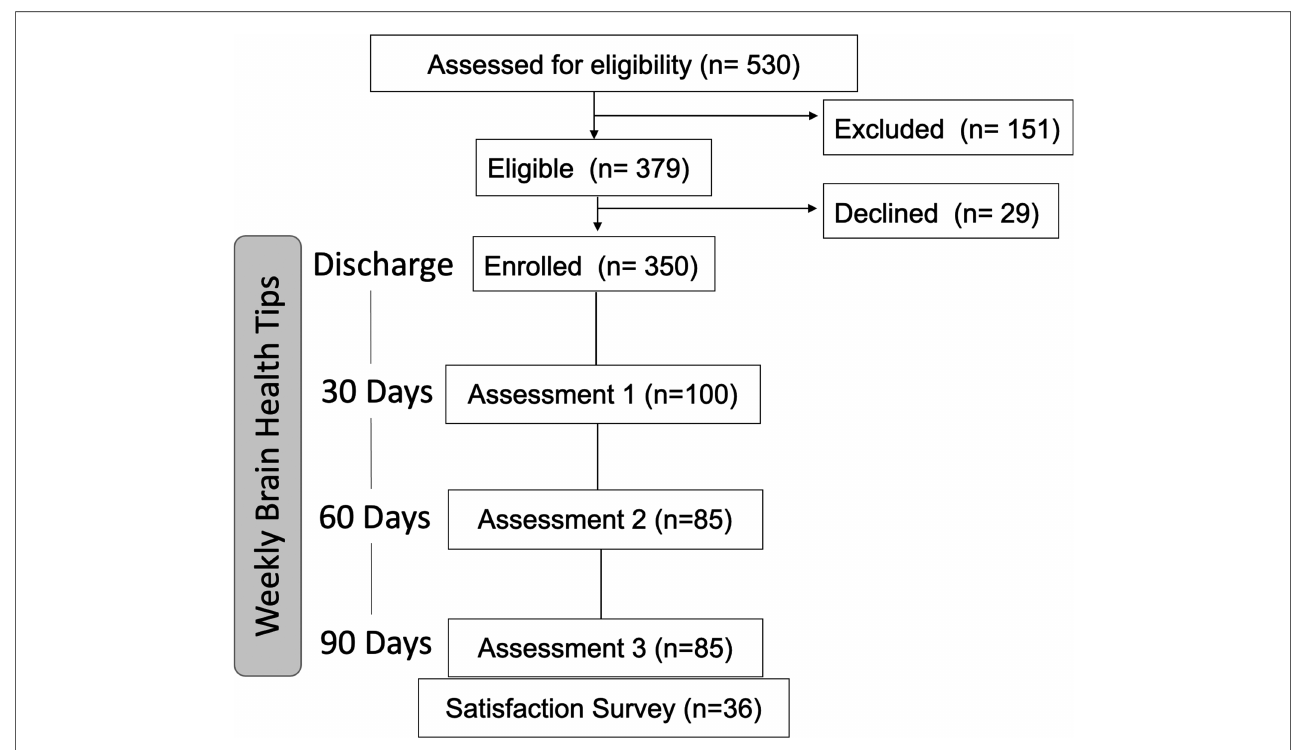
FIGURE 1 Study fl ow diagram. Cohorts at each assessment time point are